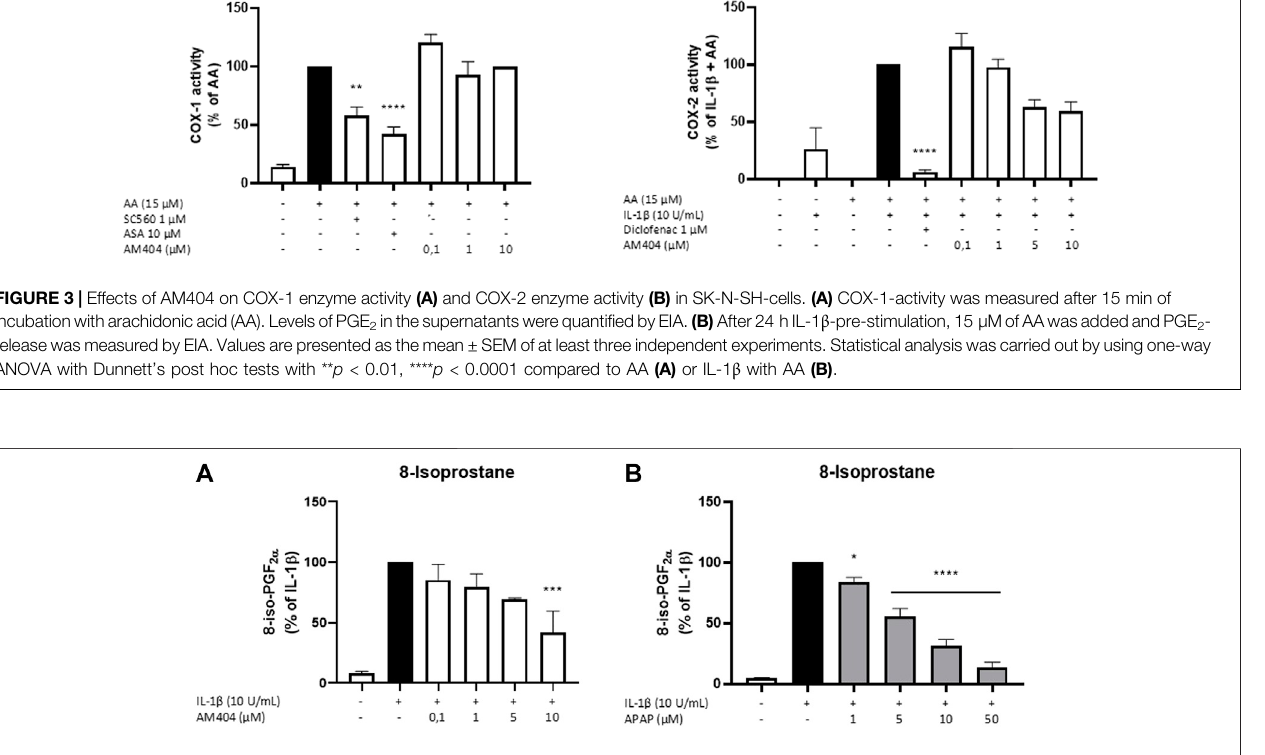
FIGURE 4 | Effects of AM404 (A) and acetaminophen (B) on 8-iso-PGF 2 α -release in IL-1 β -stimulated SK-N-SH-cells. Cells were stimulated as described under materialandmethods.After24 hofstimulation,supernatantswerecollectedandreleaseof8-iso-PGF 2 α wasmeasuredbyEIA.Valuesarepresentedasthemean ± SEM of at least three independent experiments. Statistical analysis was performed using one-way ANOVA with Dunnett ’ s post hoc tests with ** p < 0.01, *** p < 0.001, **** p < 0.0001 compared to IL-1 β